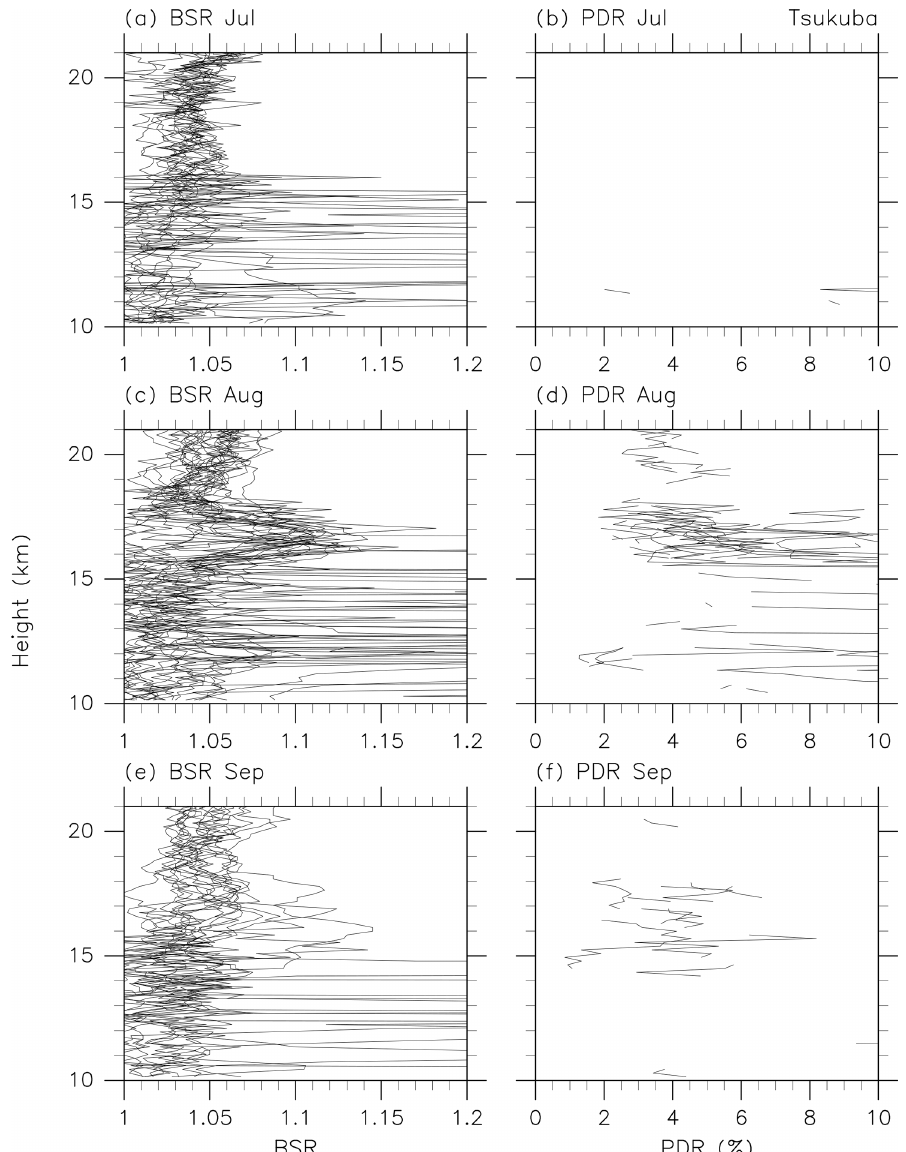
Figure 2. Vertical profiles of (a, c, e) the backscattering ratio (BSR) and (b, d, f) particle depolarization ratio (PDR, in %) in (a, b) July, (c, d) August, and (e, f) September 2018 obtained using the lidar system at MRI, Tsukuba. It is noted that strong and noisy signals in BSR below ∼ 15.5km are due to cirrus